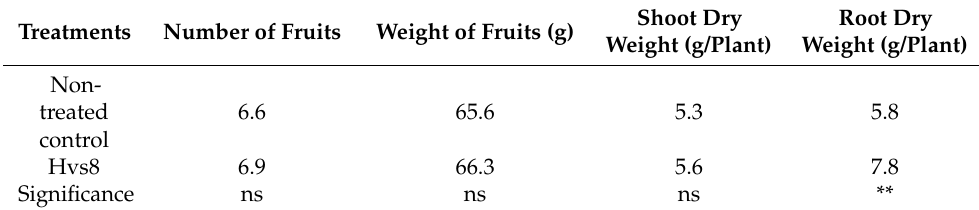
Table 3. Total number and weight of fruits, shoot dry weight, and root dry weight of strawberry plants cv. ‘Rociera’ treated with Hvs8 bacterial suspension and non-treated plants (means of the two independent greenhouse